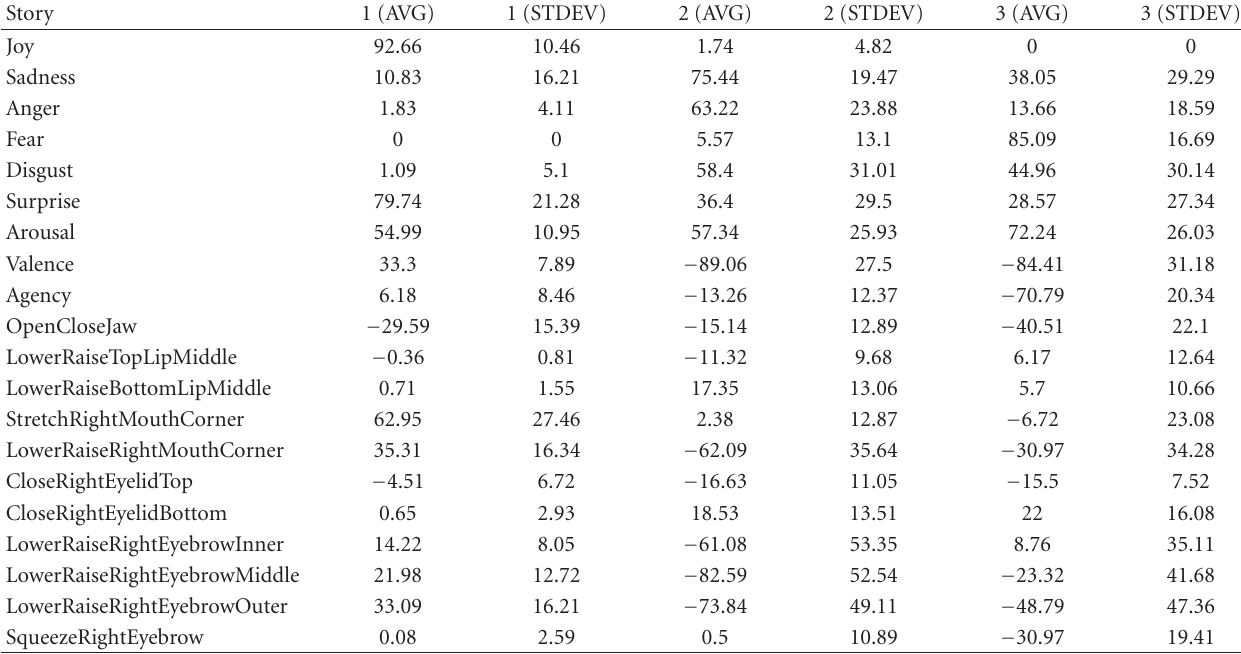
Table 4: Average and standard deviation of participant data (left-side facial action values similar to the right-side ones).